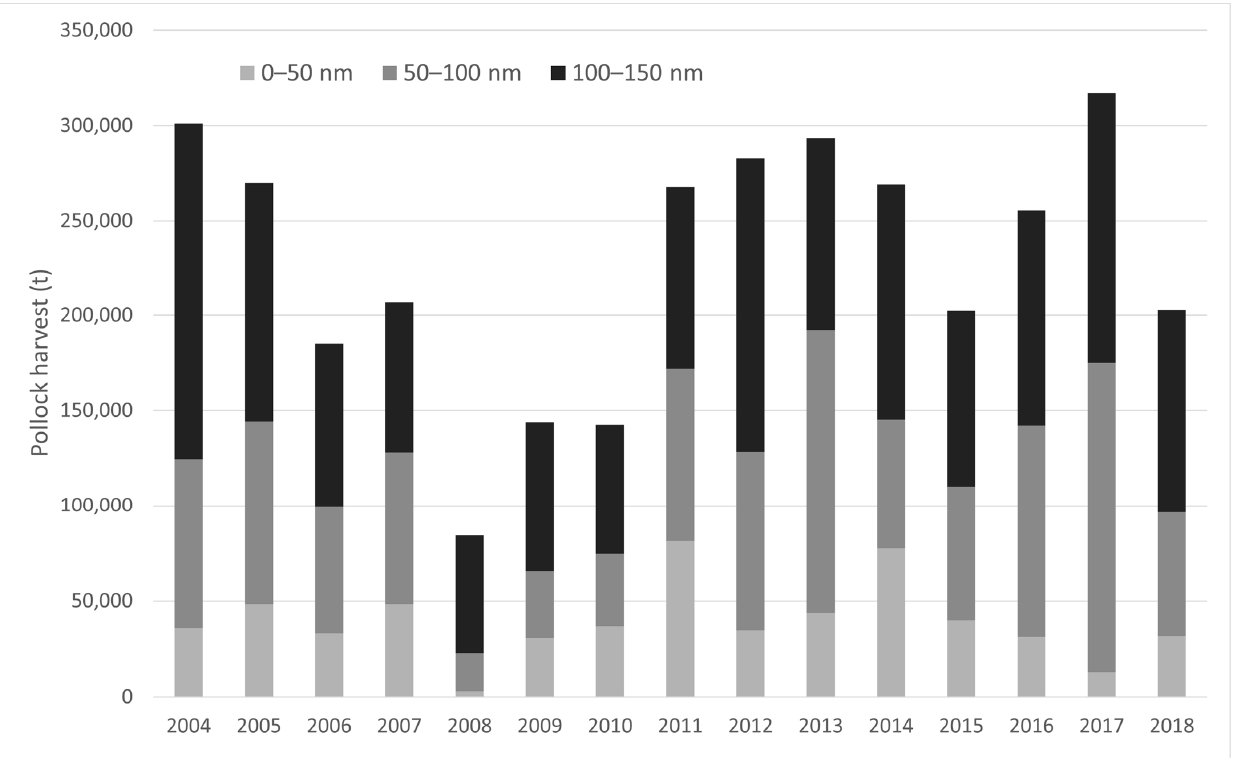
Figure 3. Annual B-season pollock harvests for MHRs within the 0–50 nm sub-region, 50–100 nm sub-region, and 100–150 nm zone (outside the PRIME) from the Pribilof Islands, 2004–2018. Table 2. Area (km 2 ) that encompasses each meta-home range (MHR) and harvest intensity (average annual tons (Avg t) pollock harvested per km 2 ) for: ( A ) 0–50 nm and ( B ) 50–100 nm MHR sub-re- gions. Percentage change represents linear model (LM) coefficients and confidence intervals, and p - values for each sub-region. MHR sub-regions with statistically significant p -values ( p < 0.05) are shaded gray. * Indicates MHR sub-regions with statistically significant p -values ( p < 0.05). (A) 0–50 nm Sub-Region